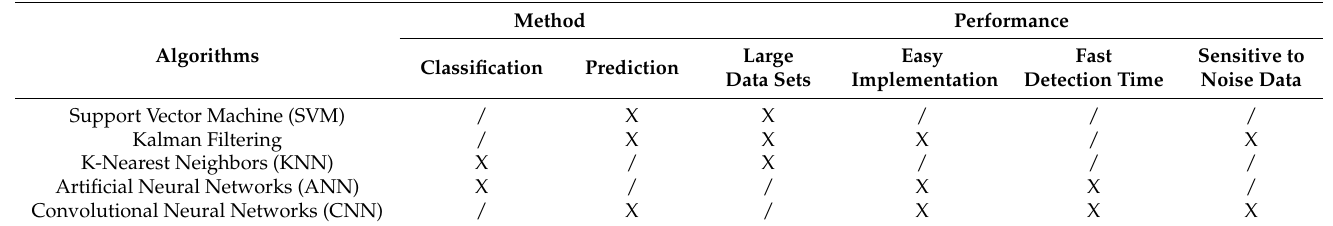
Table 4. Performance summary of algorithms discussed in water leak detection method. “/” and “X” indicate the advantages and disadvantages of the algorithm, respectively.